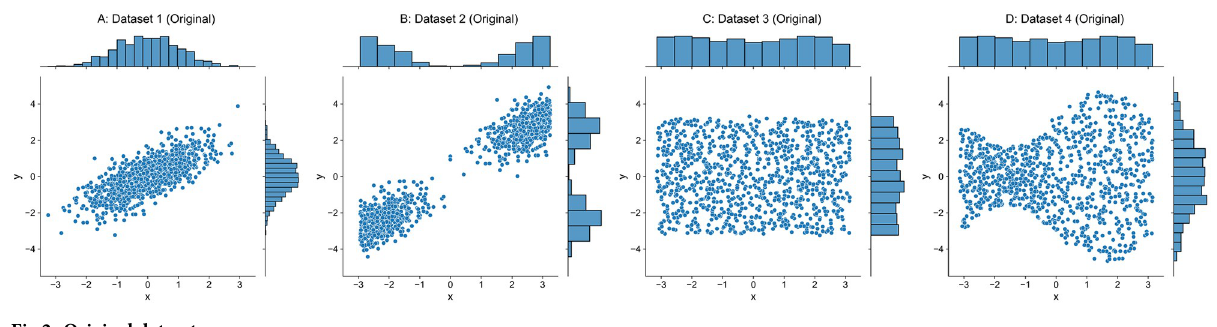
Fig 2. Original datasets.